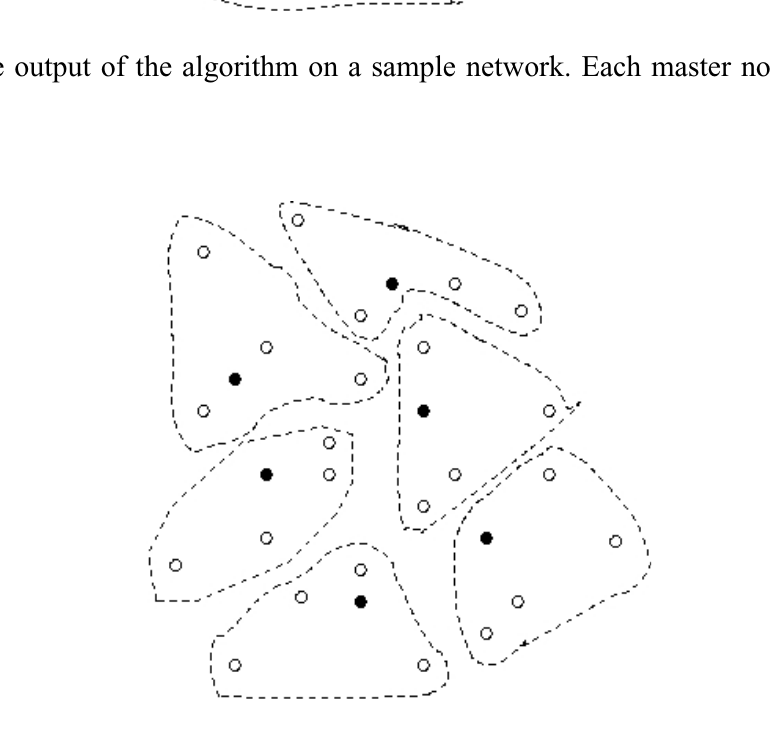
Figure 8. The effect of changing the master nodes' capacity constraint on the clustering. Each master node can handle 4 sensors in this